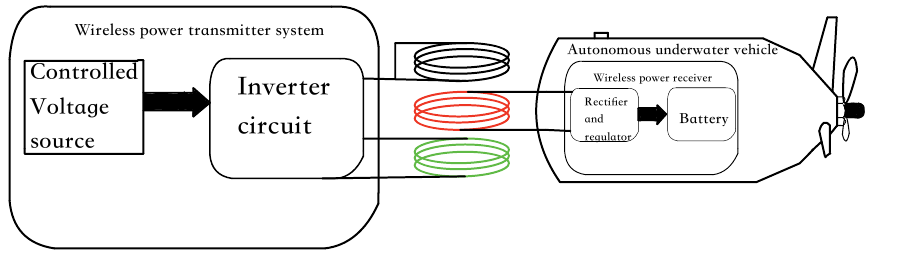
Figure 2. Block diagram of the described structure.